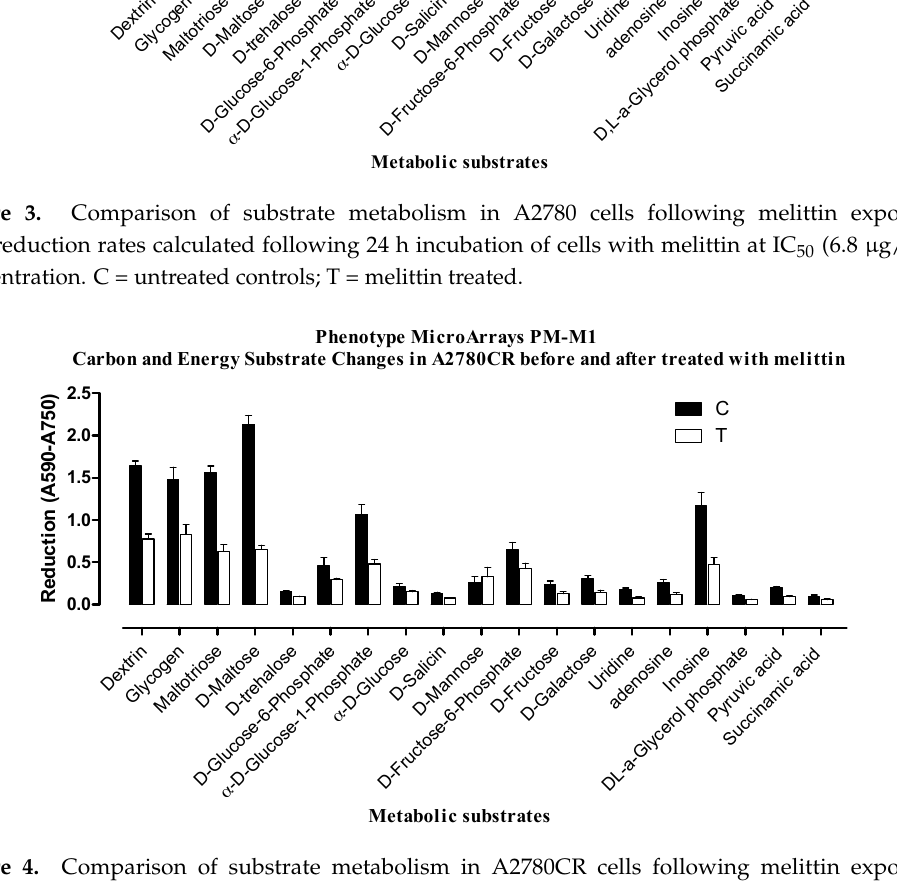
Figure 4. Comparison of substrate metabolism in A2780CR cells following melittin exposure. Dye reduction rates calculated following 24 h incubation of cells with melittin at IC 50 (4.5 µ g/mL) concentration. C = untreated controls; T = melittin treated.